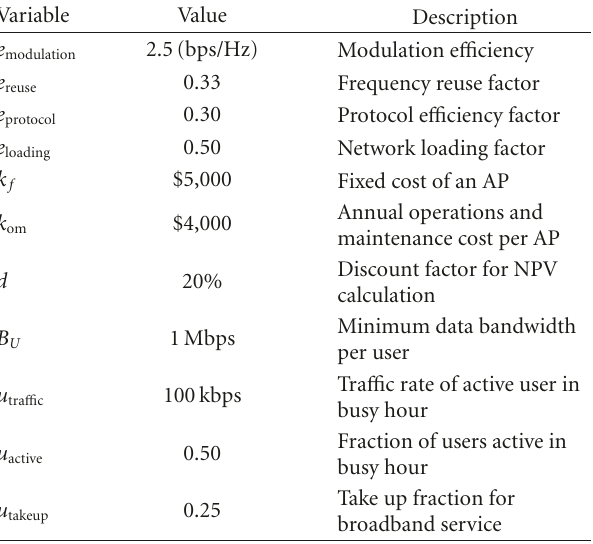
Table 4: Regime independent input variables used in the